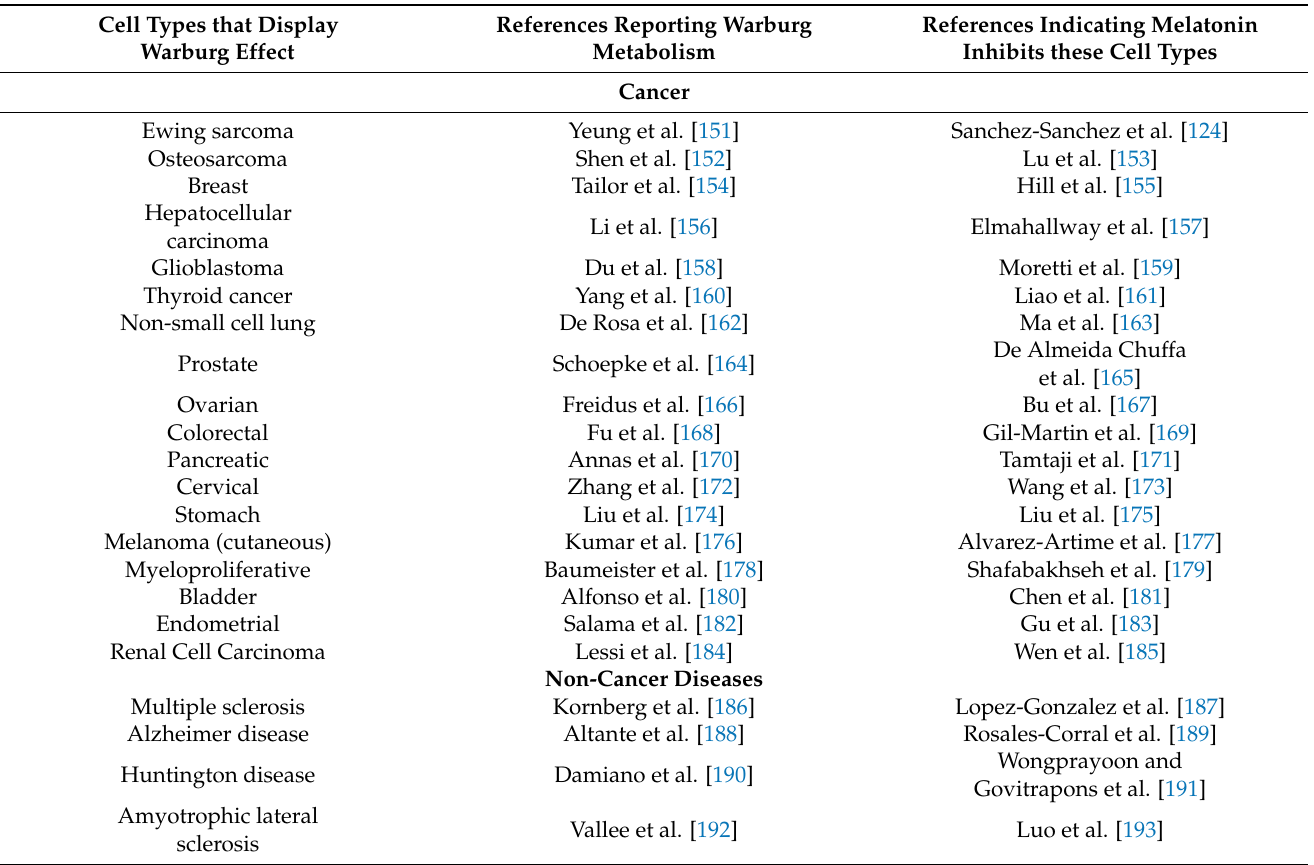
Table 1. A partial list of cell types that can experience cytosolic aerobic glycolysis. In most cases, the Warburg metabolism is considered to be associated with diseased cells; while this is almost universally valid, it is not absolute. Solid cancers, a sampling of which is listed here, often adopt Warburg-type metabolism in lieu of mitochondrial oxidative phosphorylation for ATP production. In some cells, however, both routes of pyruvate metabolism and ATP production are preserved. The table also includes an incomplete list of non-tumor, but diseased, cells which employ aerobic glycolysis. Only a single reference is cited in support of each category. In some cases, there are many more publications that document the occurrence of Warburg-type metabolism. Experimentally, melatonin has been shown to inhibit each of the pathological cell types listed (both cancer and non-cancer). Here, we propose that melatonin’s ability to reprogram cytosolic aerobic glycolysis to mitochondrial oxidative phosphorylation, at least in part, may be a unifying mechanism by which melatonin negatively impacts diverse pathological